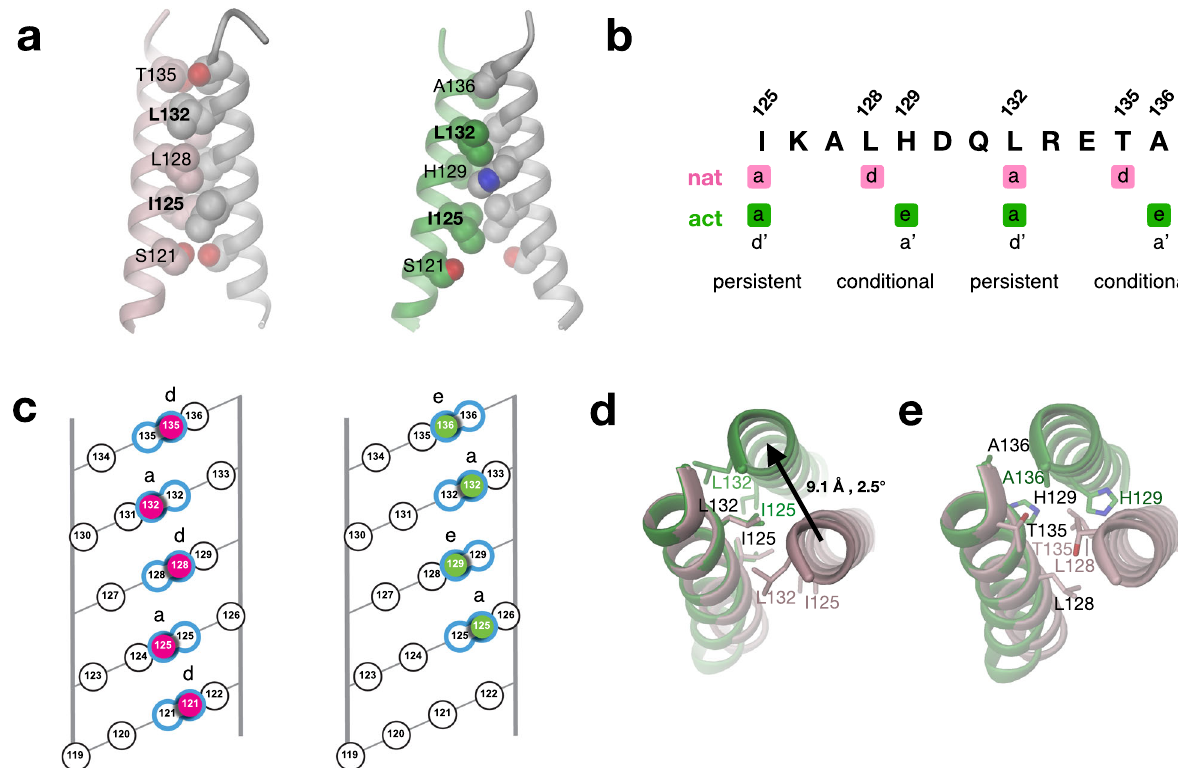
Fig. 5 Coiled-coil linker adopts two alternative registers depending on activation state. a Side view of parallel coiled-coil linker of DgcR ’ (left) and DgcR ’ * (right) with residues that form contacts with their symmetry equivalents in CPK representation. Only residues from the left helix are labelled. Bold labels indicate residues that are involved in both registers (persistent contacts). b Two alternative heptad repeat patterns (a d a d and a e a e ), which are adopted by DgcR ’ and DgcR ’ *, respectively. Positions a are used in both registers (persistent contacts), whereas positions d or e are used only in the native or activated conformation (conditional contacts). Note, that the a e a e pattern can formally also be described by a d ’ a ’ d ’ a ’ pattern as indicated in the fi gure and used in (Gourinchas et al.) 14 . c Helical net representation 51 of coiled-coil interactions in DgcR ’ (left) and DgcR ’ * (right). Of the front helix, only interacting residues are shown (highlighted by colour). Interacting residues pairs are outlined in blue. d , e Top view of coiled-coil after superposition of left helix. DgcR ’ and DgcR ’ * are shown in pink and green, respectively. For clarity, residues forming persistent and conditional contacts are shown in the separate panels d and e ,